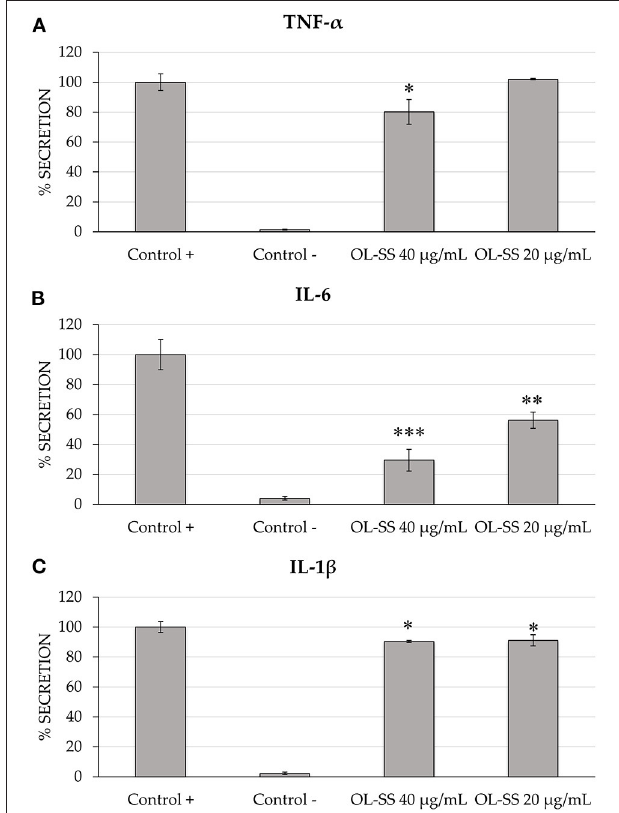
FIGURE 1 | Secretion levels of TNF- α (A) , IL-6 (B) , and IL-1 β (C) in differentiated THP-1 cells treated with and without LPS treatment (Control + and Control –, respectively), and treated with LPS in the presence of olives leaves-sea sand adsorbate (OL-SS) at 20 and 40 µ g/mL. Each bar is the mean of three determinations ± SD. *Denotes statistical differences when compared with positive control (* p < 0.05; ** p < 0.01; *** p < 0.001).